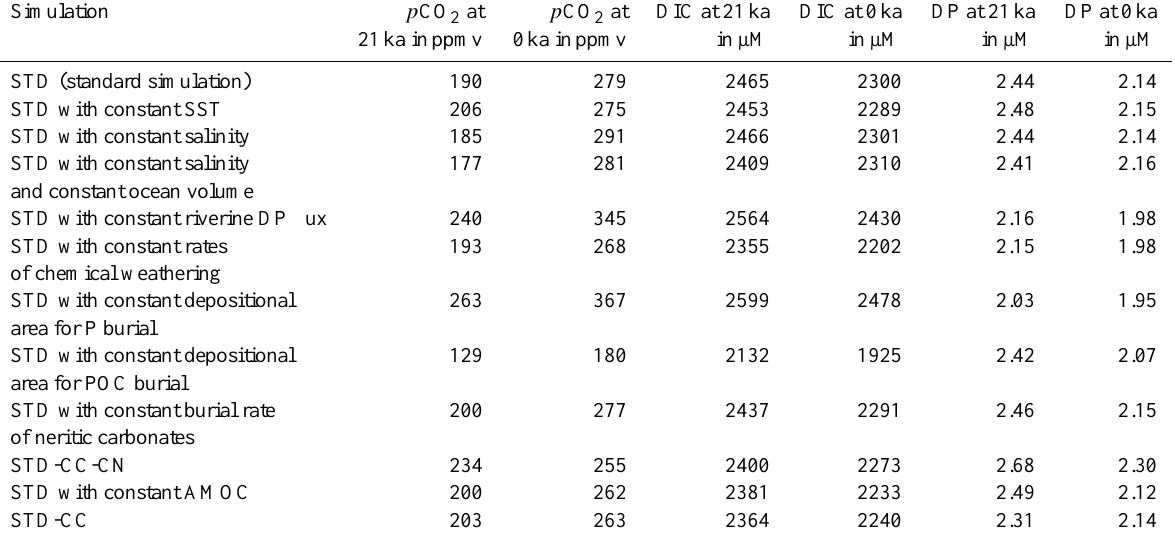
Table 1. Controls on atmospheric p CO 2 and mean dissolved carbon and phosphorus concentrations in the global ocean. Simulation p CO 2